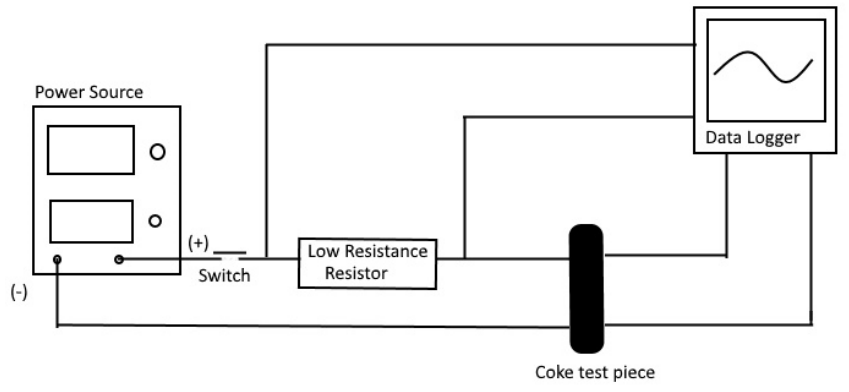
Figure 3. Schematic representation of the setup to measure ambient temperature resistivity.